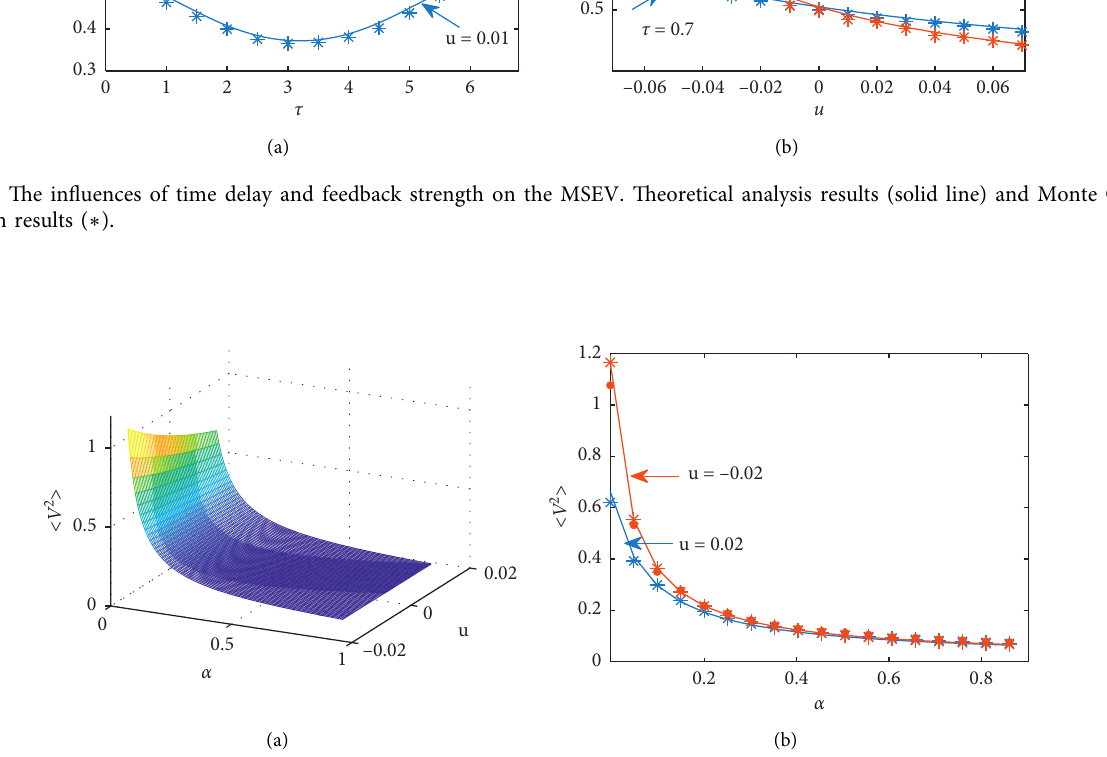
Figure 7: The influences of time delay and feedback strength on the MSEV. Theoretical analysis results (solid line) and Monte Carlo simulation results ( ∗